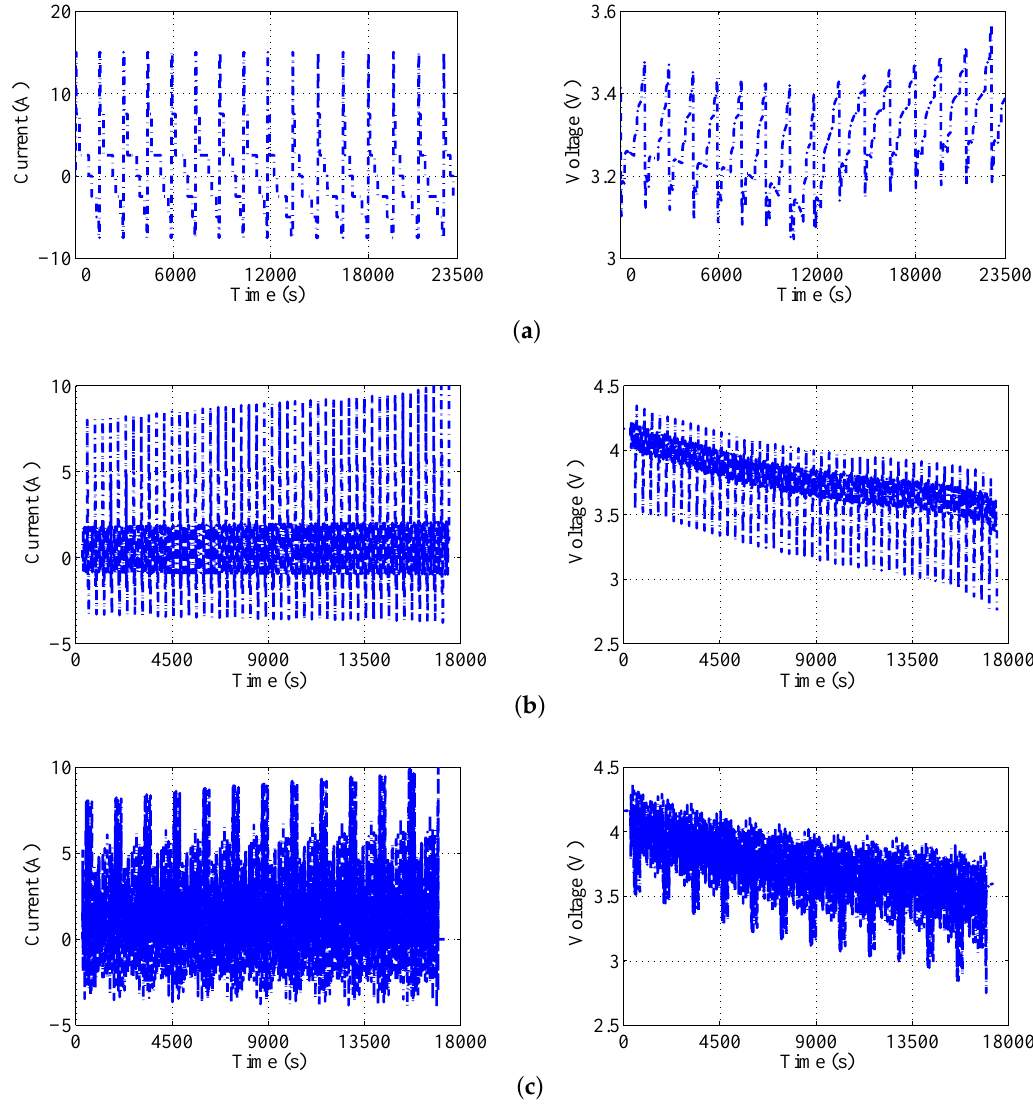
Figure 4. Dynamic current profiles and voltage responses of different tests: ( a ) HPT for one type 1 cell; ( b ) DST for one type 2 cell; and ( c ) FUDS for one type 2